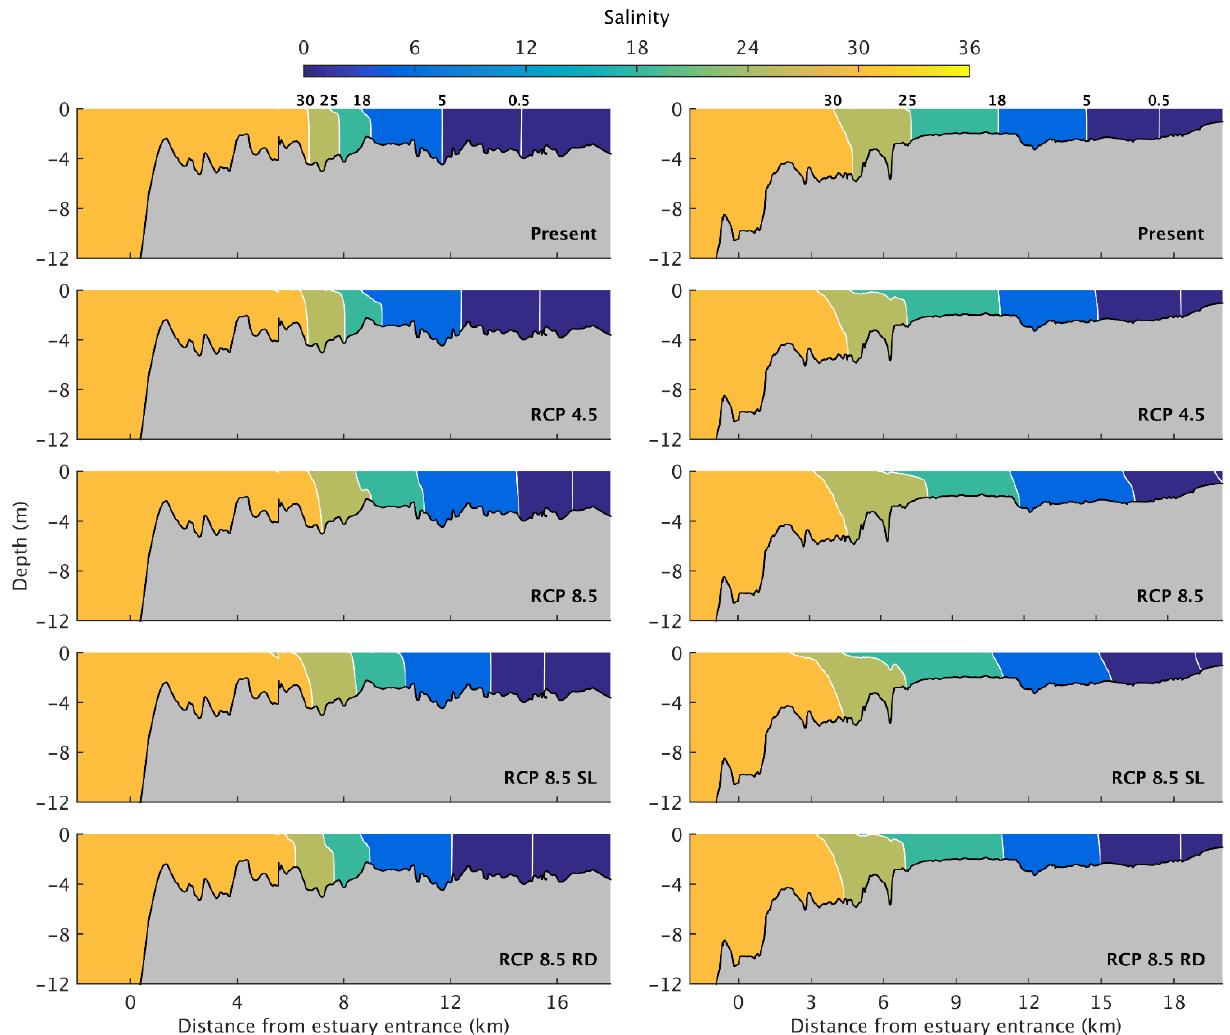
Figure 6. Longitudinal section of salinity distribution during summer conditions for the Present, RCP 4.5, and RCP 8.5 scenarios. The ( left ) panel represents the Minho estuary and the ( right ) panel the Lima estuary.